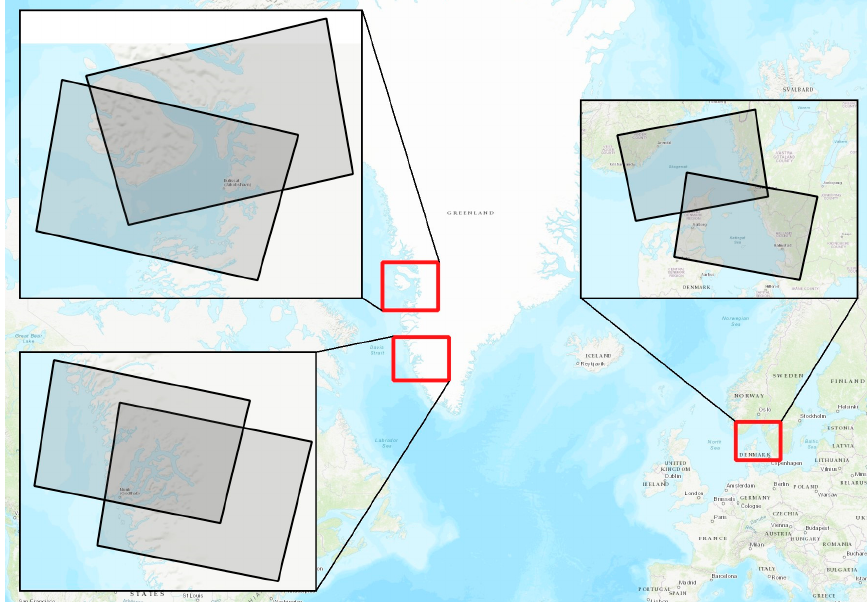
Figure 1. Study areas outlined in red and, Sentinel-1 scenes used within the study areas outlined in black. Table 1. Information on acquired satellite data for annotation of ship and icebergs.